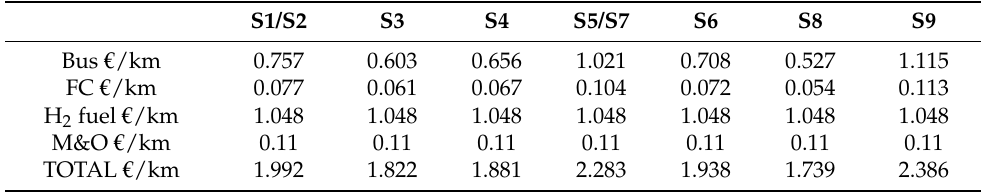
Table 11. TCO calculated for dataset related to 2020.